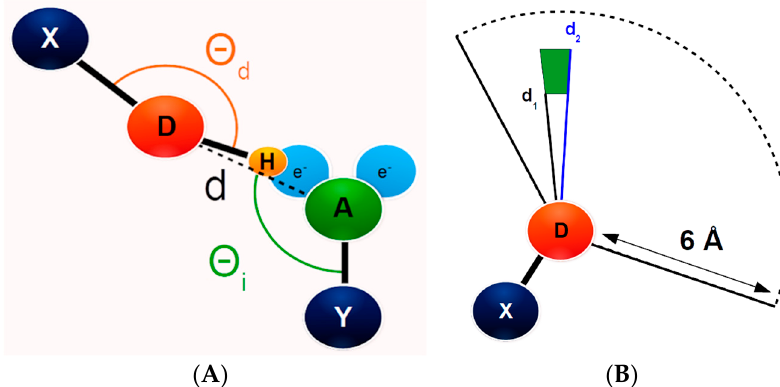
Figure 1. Graphical illustration of the geometric definition of hydrogen-mediated interactions (HMI). ( A ) Illustration of the heavy atoms which are included in the HMI definition including the two electronegative atoms (hydrogen atom donor D and hydrogen atom acceptor A) and their partners, X and Y, respectively. The distance between D and A is illustrated as distance d. The direct angle between X, D, and A ( Θ d , orange) and the indirect angle made up of points Y, A, and D ( Θ i , green) are also illustrated. ( B ) Demonstrative side view showing the annular shape of the volume of each bin in space. Each bin is 0.1 Å and 1° between d 1 and d 2 so a cone correction is applied to compensate for the greater volume of the longer distance bins.